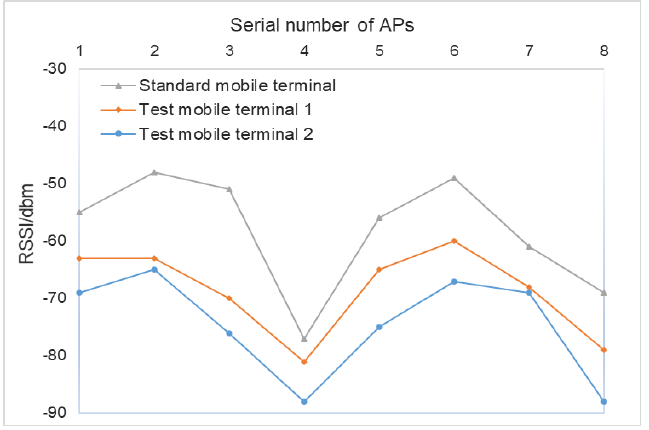
Figure 1. RSSI received by different mobile terminals in the same direction at the same position at the same time.